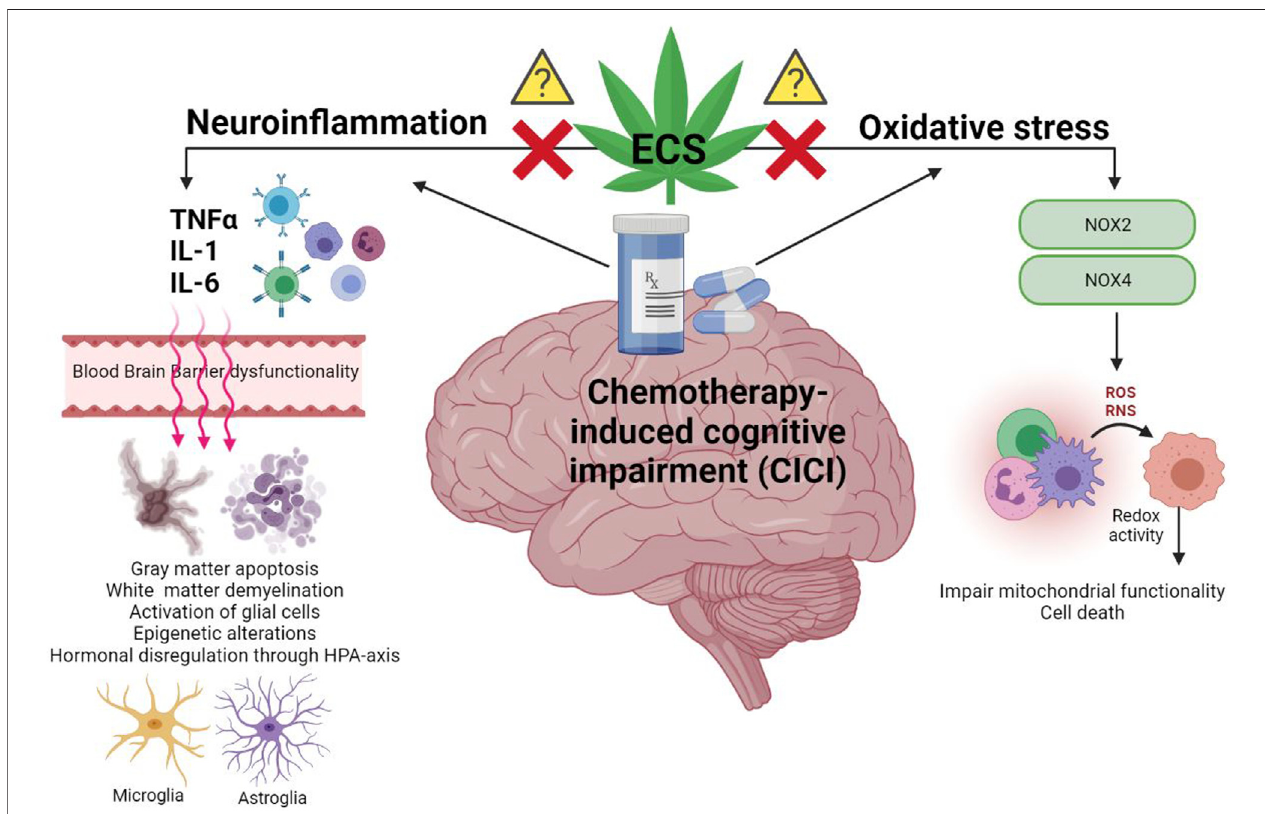
FIGURE 1 | Graphic representation of the neuroin fl ammatory processes and oxidative stress underlying chemotherapy-induced cognitive impairment (CICI). The activation of the pro-in fl ammatory cascade, following chemotherapeutic drug administration, is characterized by the central/peripheral release of pro-in fl ammatory cytokines such as TNF α , IL-1 and IL-6. Transport of these cytokines through the blood brain barrier (BBB) affects its functionality, facilitating, thus, the access of further cytokines and chemotherapeutic drugs into the supraspinal central nervous system (CNS). Therefore, persistent neuroin fl ammation in the CNS alters brain ’ s plasticity and functionality mediating the development of cognitive alterations. The commencement of oxidative stress cascade, following chemotherapeutic drug administration, is characterised by the activation of NOX2/NOX4 enzymes which synthesize oxygen and nitrogen reactive species (ROS and RNS, respectively). IncreasedredoxactivityduetointracellularaccumulationofROS/RNSinducesproteinandDNAisoformsalterationsthatleadtocelldeath.Theendocannabinoidsystem (ECS), as previously described in similar cognitive-related alterations, proposes a new target for the inhibition of neurotoxicity, providing thus neuroprotection. However, the mechanisms through which the ECS may mediate this process are still unknown in CICI pathology.